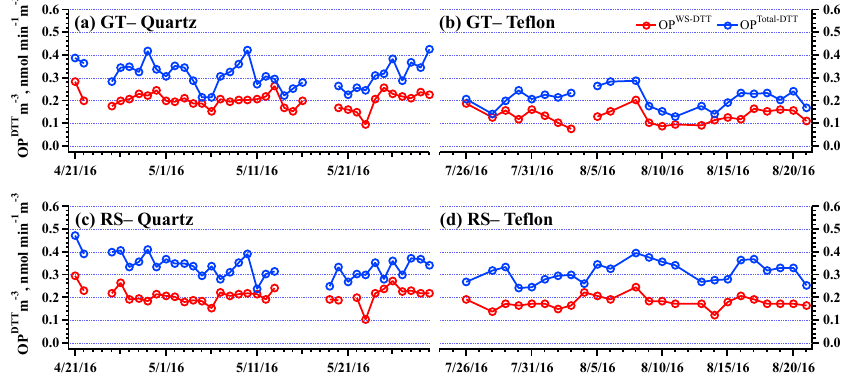
Figure 8. Volume-normalized OP DTT of ambient PM 2 . 5 particles collected on quartz and Teflon filters at GT and RS sites for two different sampling time periods. Red lines indicate volume-normalized OP WS-DTT , and blue lines denote volume-normalized OP Total-DTT .